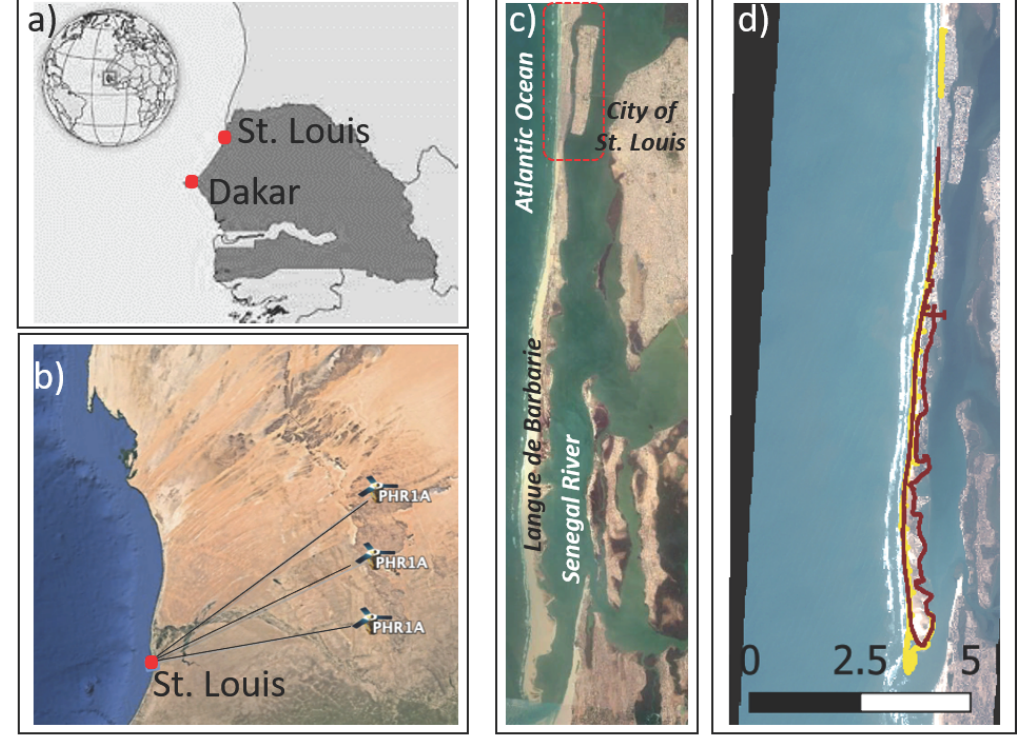
Figure 1. ( a ) Localisation of the city of Saint Louis (Senegal). ( b ) Data acquisition by Pleiades satellite. ( c ) Overview of the Langue de Barbarie and localisation of the urban area in red. ( d ) localisation of the in situ data—March 2019 in red and March 2020 in yellow with a km